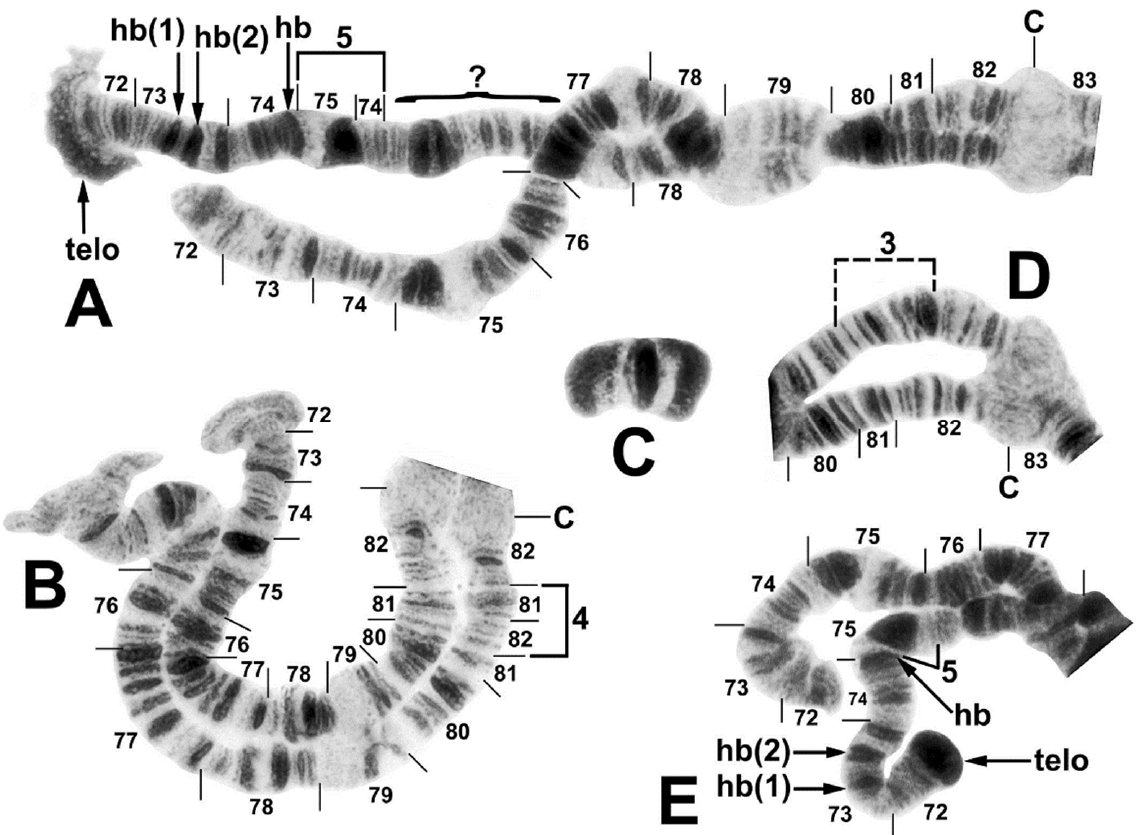
Figure 3. Chromosome IIIS (male larvae) and supernumerary B chromosome (female larva) of the Simulium ornatum group from Kyrgyzstan; C, centromere. ( A ) IIIS heterozygous for repatterning (site 5). The repatterned homologue shows inversion IIIS-5, a flared and amplified telomere (telo), and 3 heterobands (hb) in sections 73 and 74, of which the middle band is a doublet; sections 75–76 could not be reconciled with the standard homologue and are indicated with a bracket and query mark. ( B ) IIIS heterozygous for IIIS-4 (site 85), bracketed; the upper homologue shows the standard sequence for the subgenus Simulium . The distal ends of both homologues are flared. ( C ) Supernumerary B chromosome (site 21). ( D ) Base of IIIS heterozygous for Y-linked IIIS-3; the inversion is bracketed (site 34). ( E ) End of IIIS heterozygous for repatterning (site 5); the features are the same as in ( A ), although the amplified telomere is